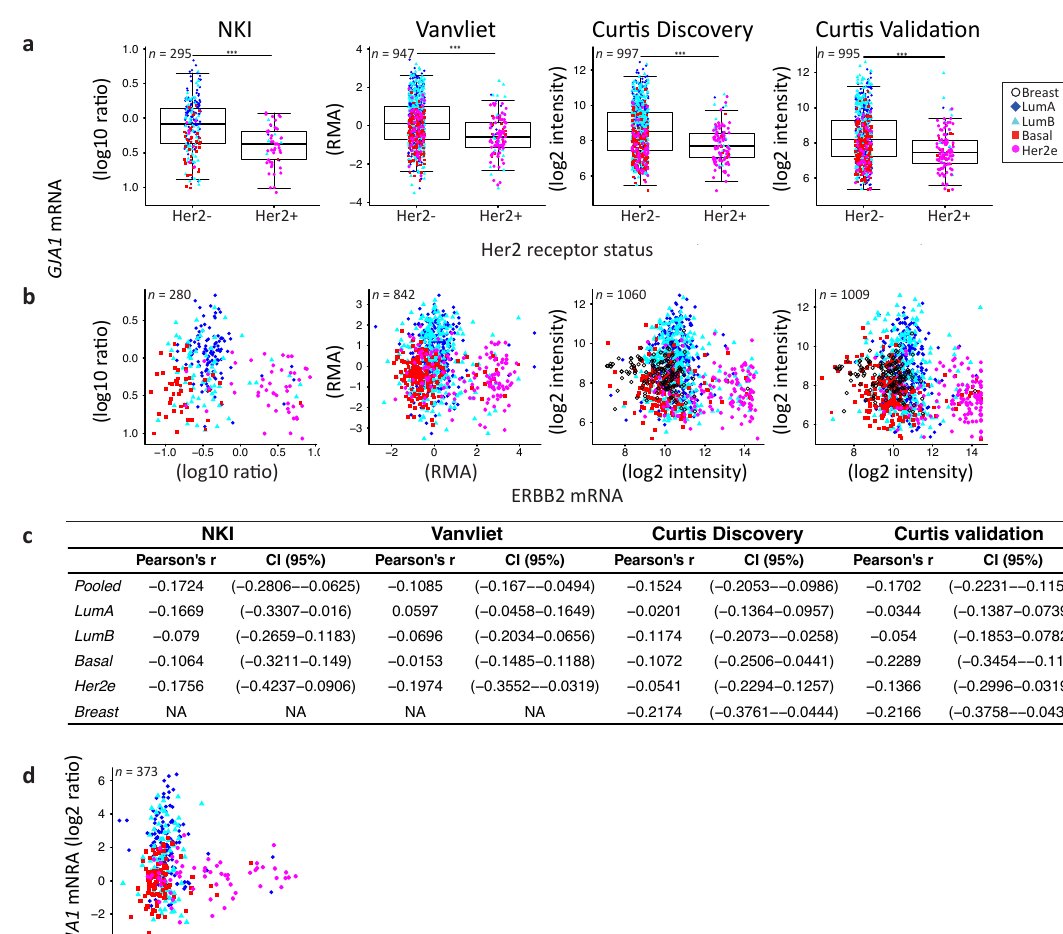
Figure A4. GJA1 mRNA level in breast cancer clinical samples is lower in HER2-positive breast tumors in four datasets. ( a ) GJA1 mRNA level in breast tumors stratified by HER2 status determined as described in Material and Methods. In the legend, “Breast” indicates adjacent normal breast tissue. p value: * <0.05; ** <0.01; *** <0.001. ( b ) Expression of GJA1 vs. ESR1 mRNA in each subtype and in normal breast tissue. ( c ) Bootstrapped correlations between ERBB2 and GJA1 mRNA level either in pooled breast cancer tumors or in individual intrinsic subtypes and in normal breast tissue. Data from Vanvliet, NKI, Curtis Discovery and Curtis validation datasets. ( d ) GJA1 mRNA vs. pY1248 phosphorylated form of HER2 protein level determined by RPPA in breast tumors from the TCGA